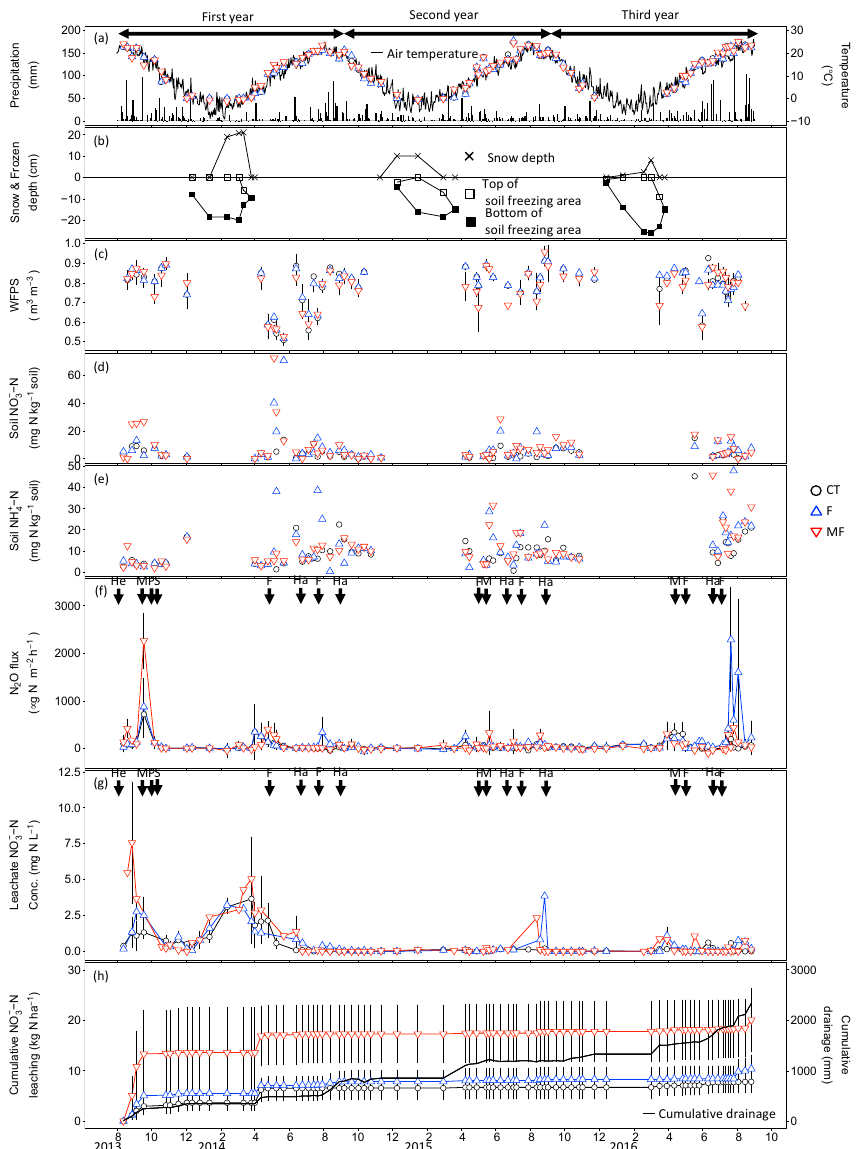
Figure 1. Daily change of precipitation, air and soil temperature depth ( a ); snow and soil freezing depth ( b ); water-filled pore space (WFPS) ( c ); soil NO 3 − –N concentration ( d ); soil NO 3 − –N concentration ( e ); N 2 O flux ( f ); leachate NO 3 − –N concentration ( g ) and cumulative drainage volume and NO 3 − –N leaching ( h ). Error bar show standard deviation. CT is unfertilized control plots ( fertilizer plots ( (cid:52) ); MF is combined manure and chemical fertilizer plots ( (cid:53) ). Black allows for letters indicates the timing of management as He: Herbicide application, P: Plowing, S: Seeding, F: Chemical fertilizer application, M: Manure application, Ha: